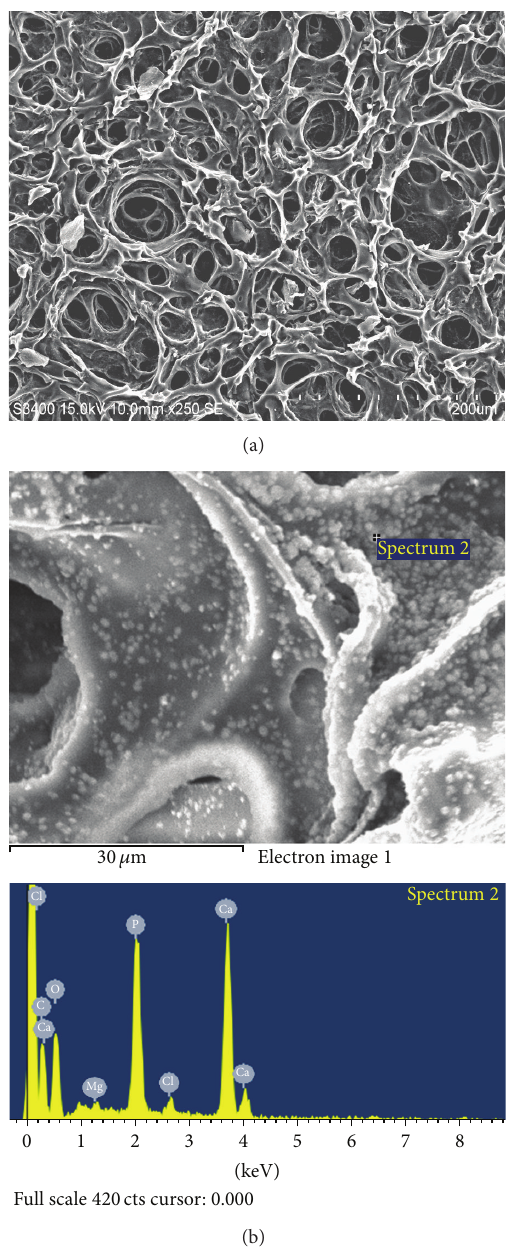
Figure 8: SEM images of NIH3T3 fibroblasts cells on grafted PVA- g-chitosan 3D scaffolds after 5 days of culture ((a) original material, (b) materials with cells, × 3000 and EDS